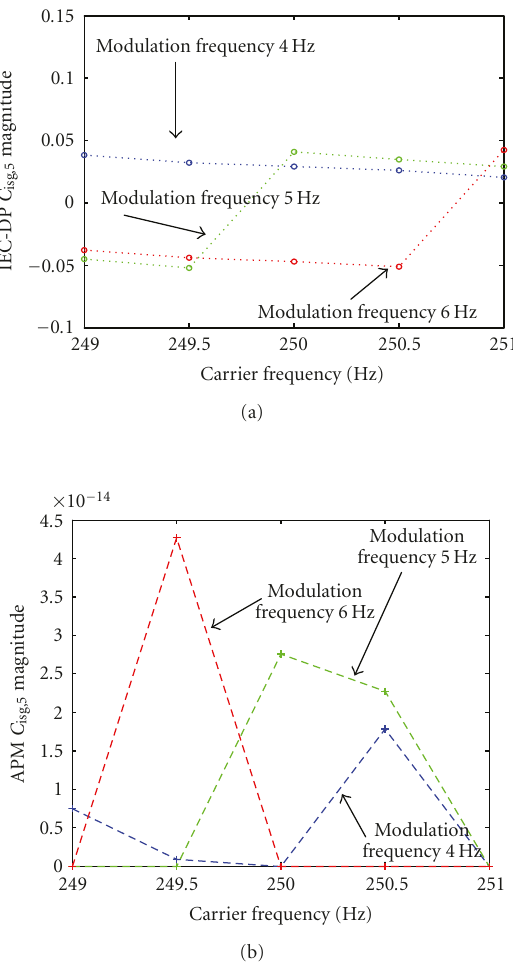
Figure 14: Case study 4: interharmonic subgroup C isg,5 magnitude versus the carrier frequency for three modulation frequencies: (a) IEC-DP (dotted line ◦ ), (b) APM (dotted line